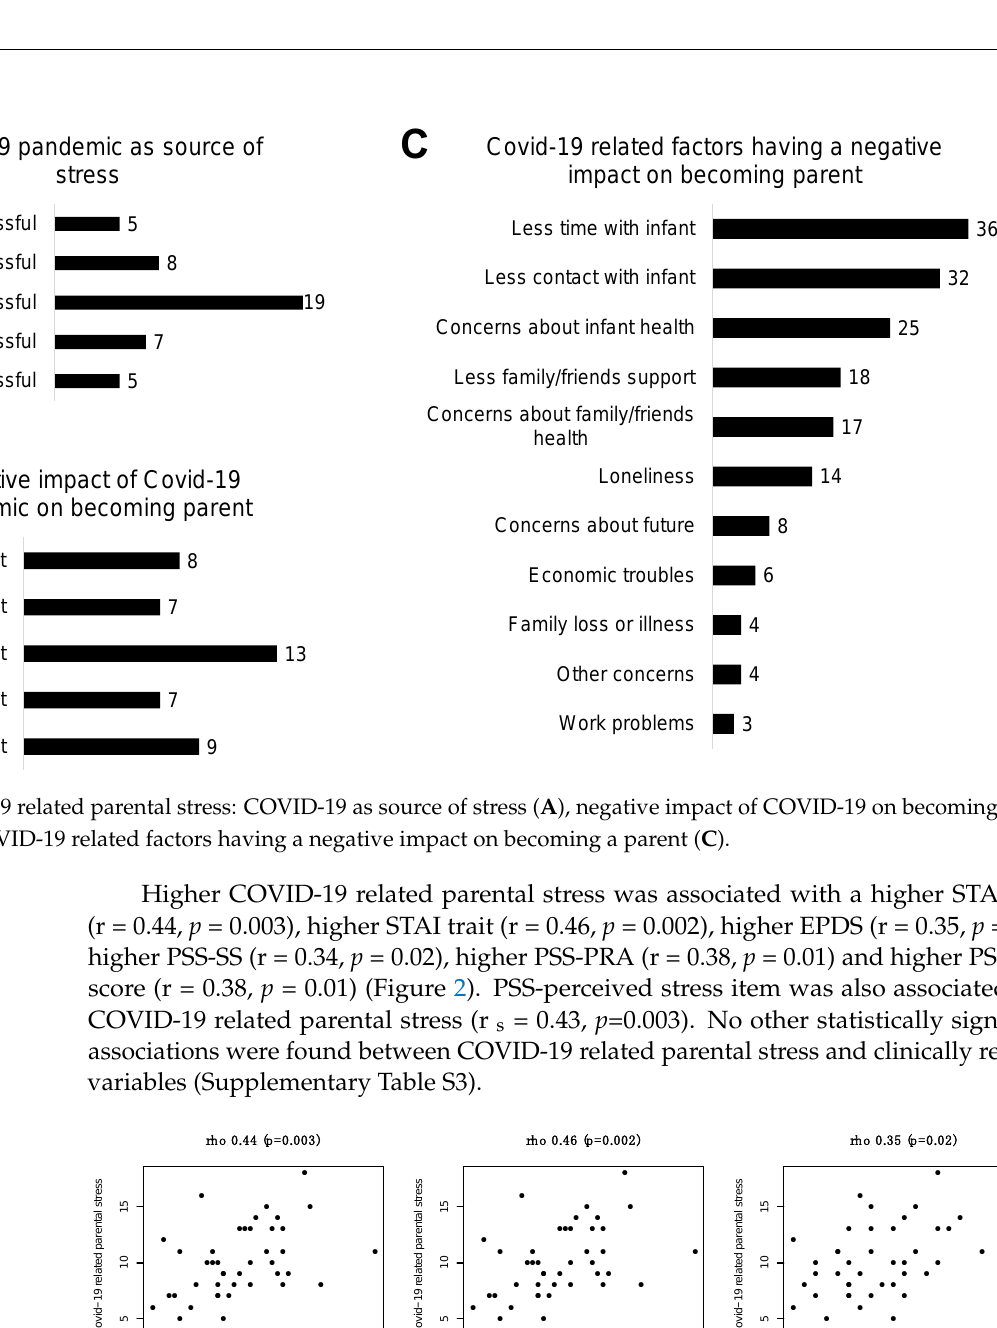
Figure 2. Association between COVID-19 related parental stress and STAI state, STAI trait, EPDS, PSS-SS, PSS-PRA and PSS-total score.